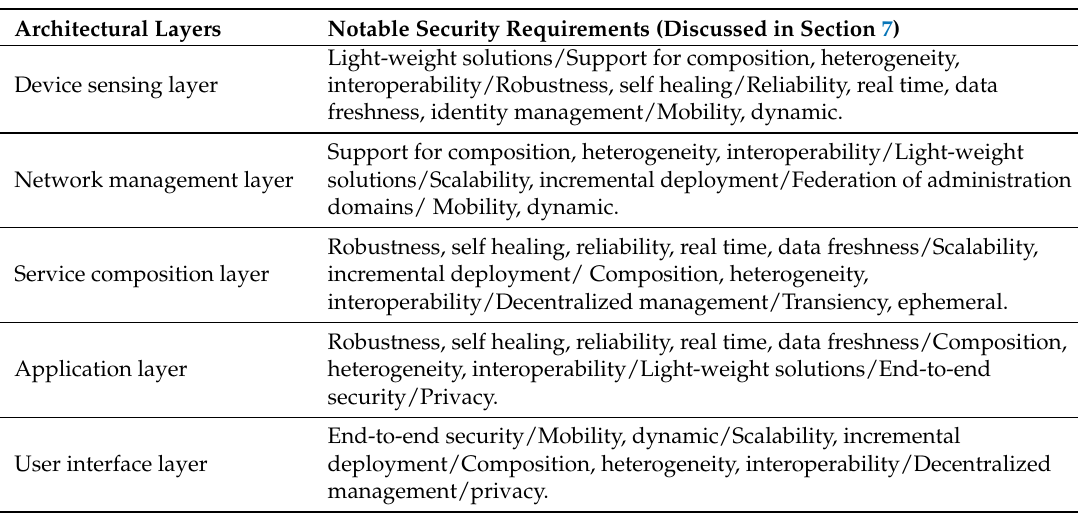
Table 7. Some notable security requirements in different layers of an IoT security architecture discussed in Figure